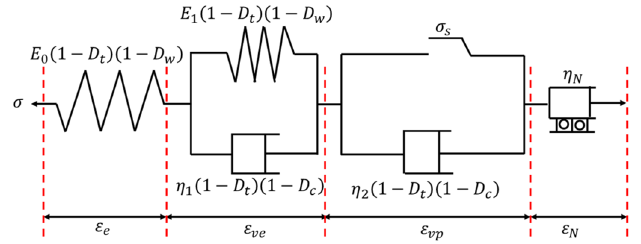
Figure 9. Improved Nishihara